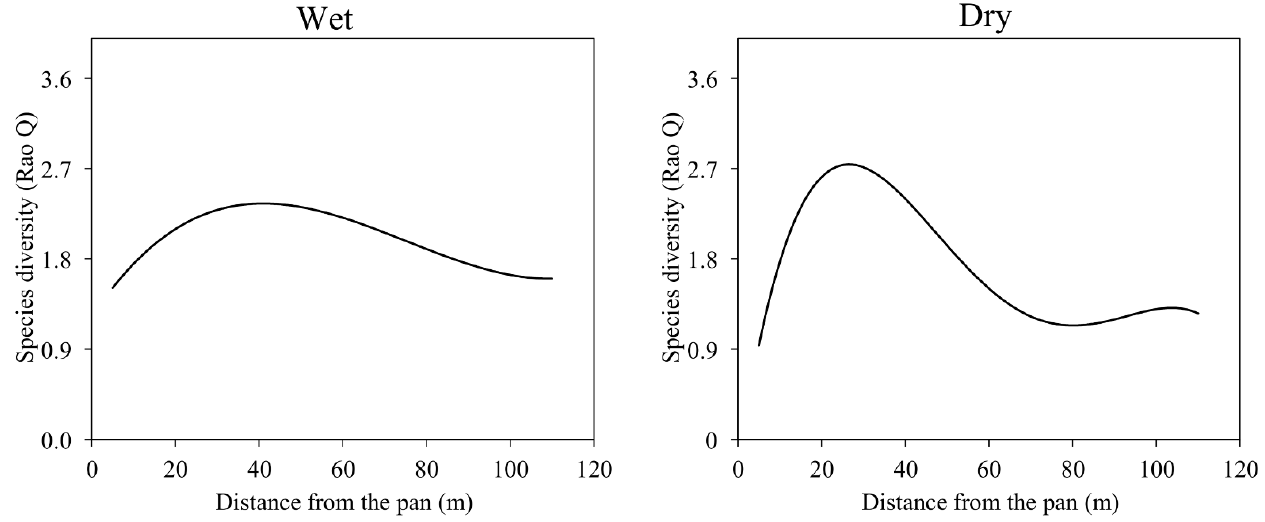
Figure 8. The response of remotely sensed vegetation diversity (Rao’s Q) to distance from the natu-